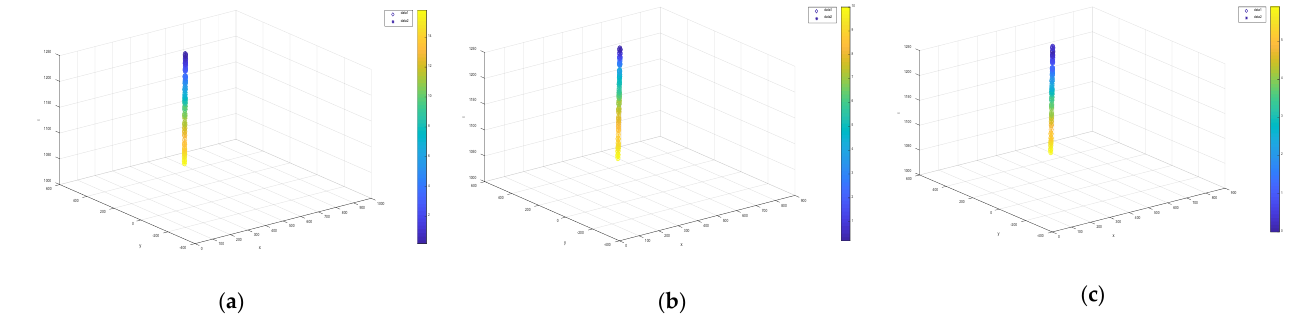
Figure 16. Object time − space 4D positioning prediction results. ( a ) Predicted results of object four-dimensional positioning at a speed of 20 mm/s; ( b ) predicted results of object four-dimensional positioning at a speed of 40 mm/s; ( c ) predicted results of object four-dimensional positioning at a speed of 60 mm/s.